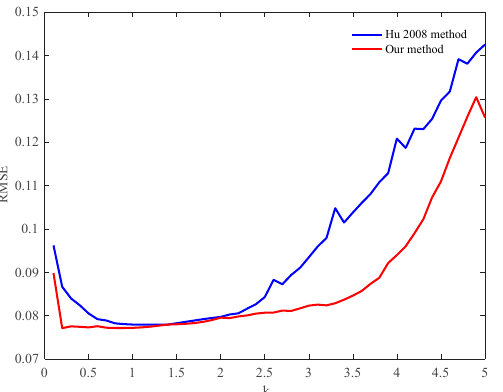
Figure 6. The relationship between k and RMSE in the data of measured K-distribution.